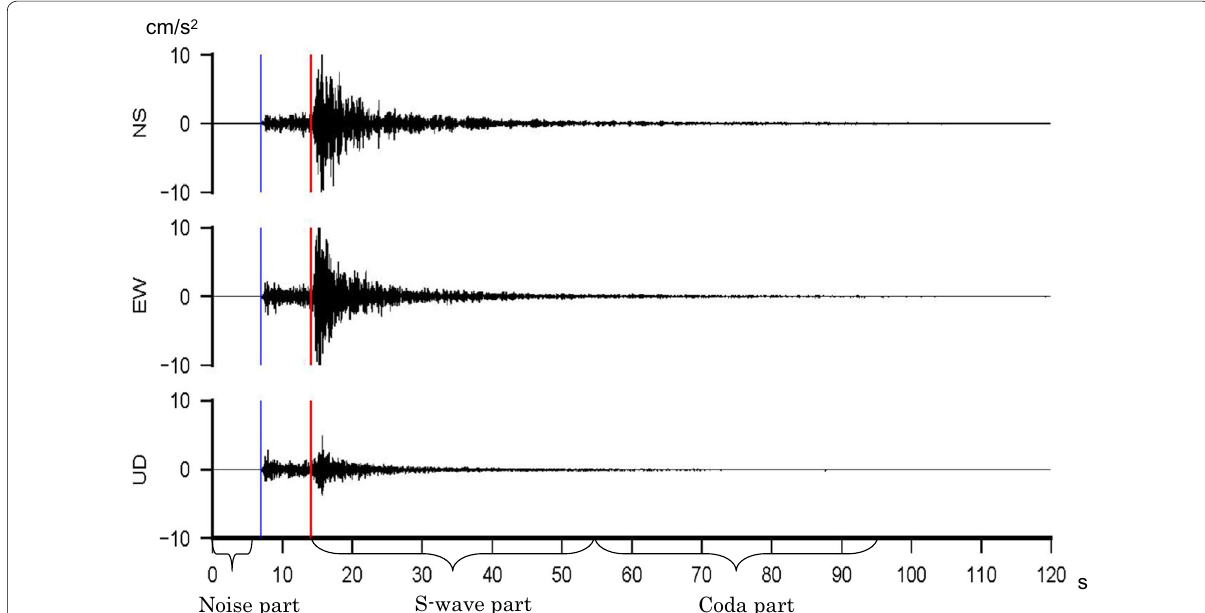
Fig. 2 Example of a measured earthquake waveform at EHM012 and sections of noise, S-wave, and coda